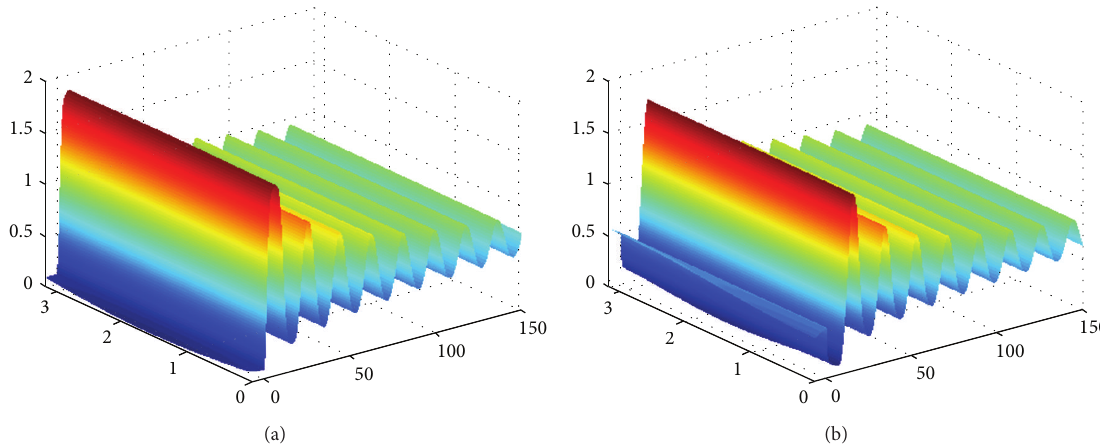
Figure 2: Convergence to positive equilibrium. Here the parameters are assumed to be 𝜏 1 = 0 , 𝜏 2 = 7 , and the initial values 𝑢(𝑥,𝑡) = 0.1 + 0.01𝑡 sin 𝑥 , V (𝑥, 𝑡) = 0.5 + 0.01𝑡 cos 𝑥 , and 𝑡 ∈ [−7,0] , 𝑥 ∈ [0,𝜋] .